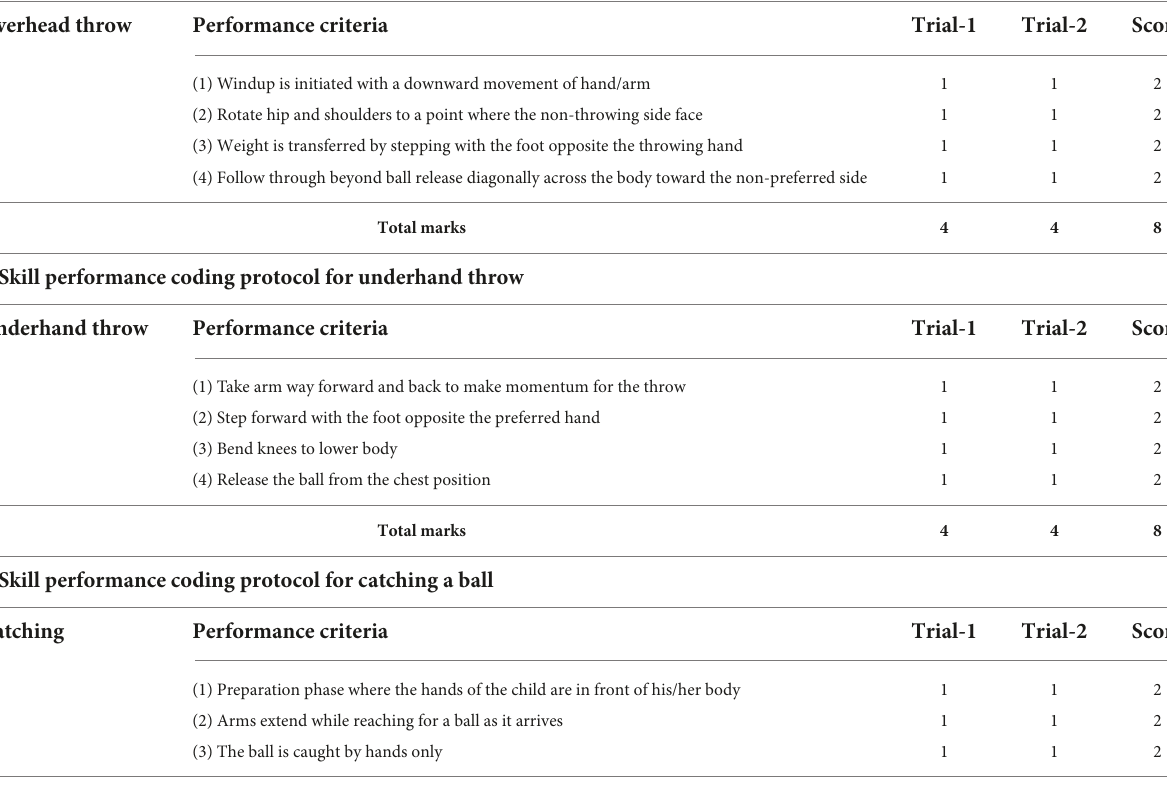
TABLE 1 Skill performance test criteria for scoring. 1. Skill performance coding protocol for overhead throw